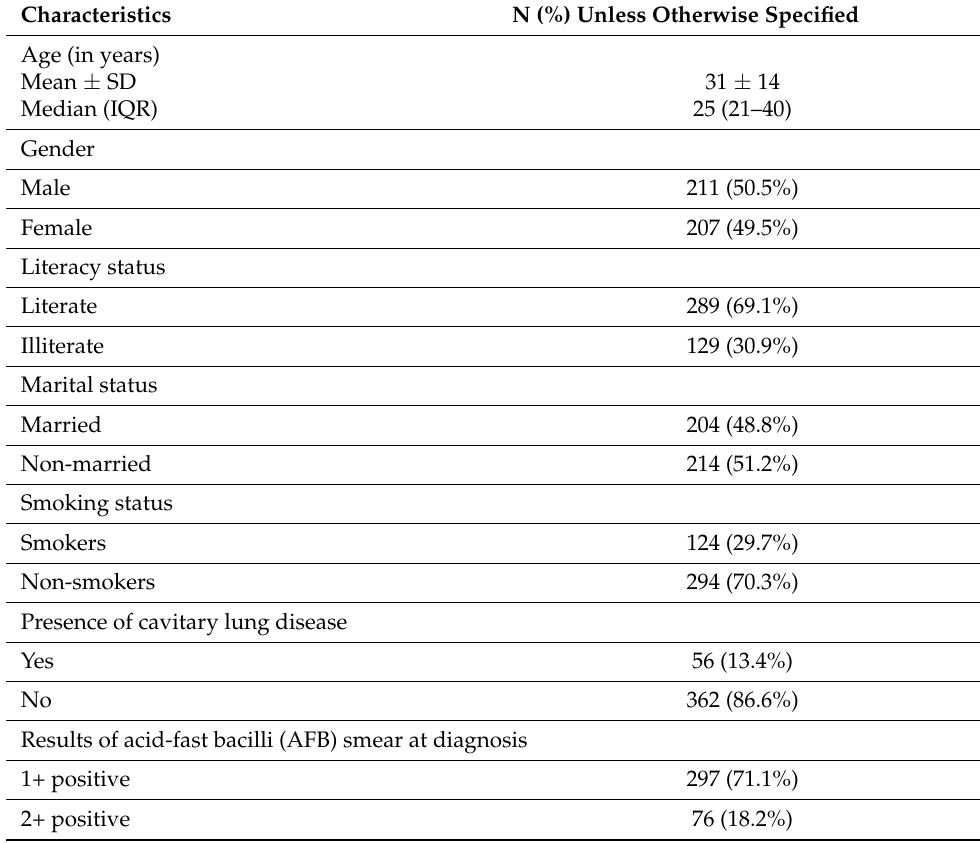
Table 1. Sociodemographic and clinical data of the patients (n =